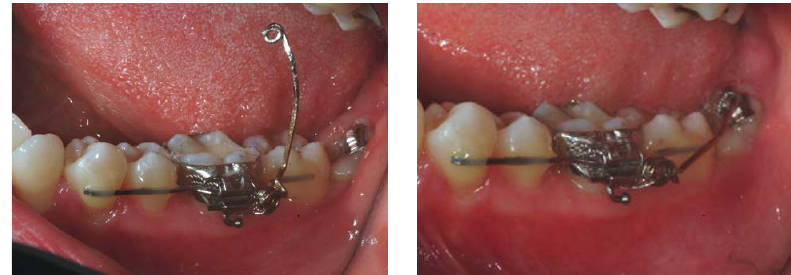
Figure 1. Clinical view of an example of an orthodontic appliance used for OE.